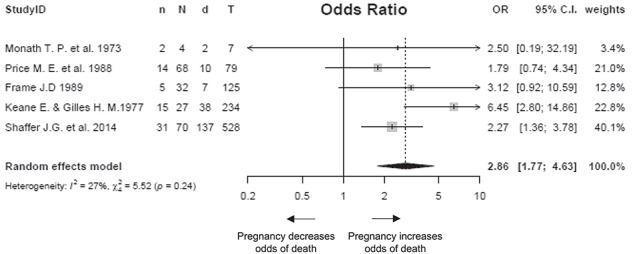
Forest plot showing the risk of death from Lassa fever in pregnant women compared with non-pregnant women. I2, Higgins statistic, τ2, tau squared; p, p-value associated with Cochran's Q for heterogeneity; LF, Lassa fever; n, number of maternal deaths; N, total number of pregnant women included in the analysis; d, number of deaths in non-pregnant women; T, total number of non-pregnant women included in the analysis.